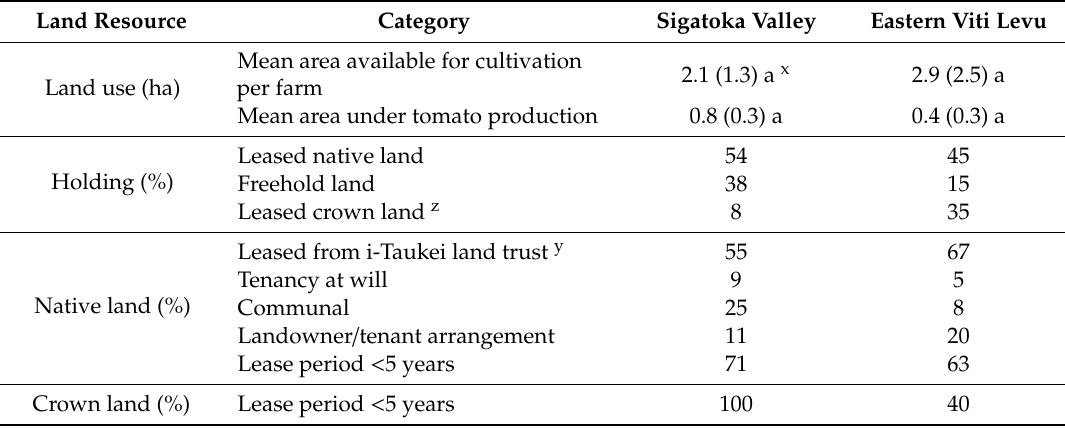
Table 2. Land use and access for smallholder tomato farmers in the Sigatoka Valley and eastern Viti Levu,